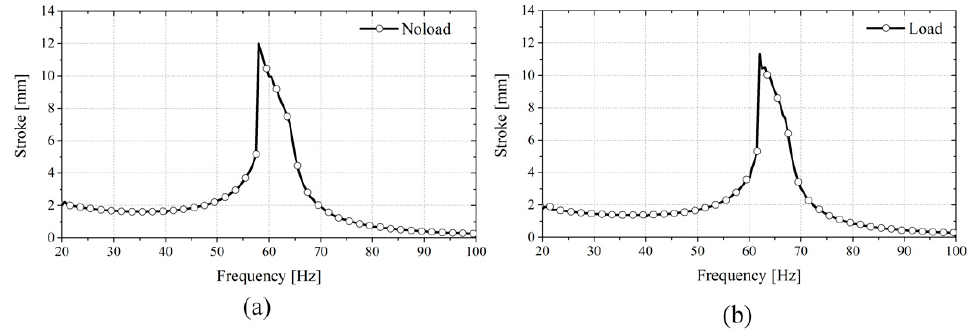
Figure 13. Current and displacement analysis results: ( a ) No load ( b ) Load.